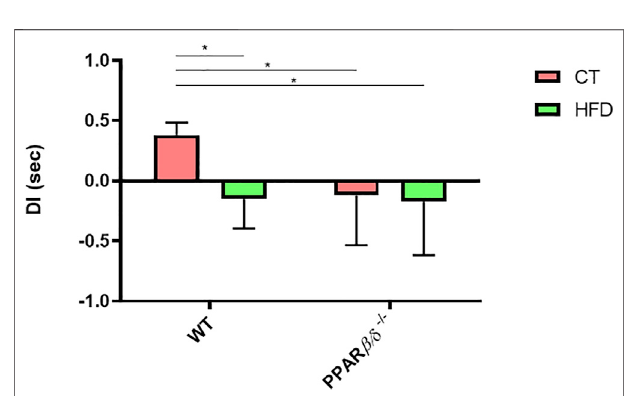
FIGURE 2 | NORT, DI expressed in seconds (Number of animals ≥ 10). Statistical analysis was performed by two-way ANOVA and Tukey post-test (WTCTvs.WTHFD:*denotes p < 0.05;WT CTvs. PPAR β / δ -/- CT:*denotes p < 0.05; WT CT vs. PPAR β / δ -/- HFD * denotes p <